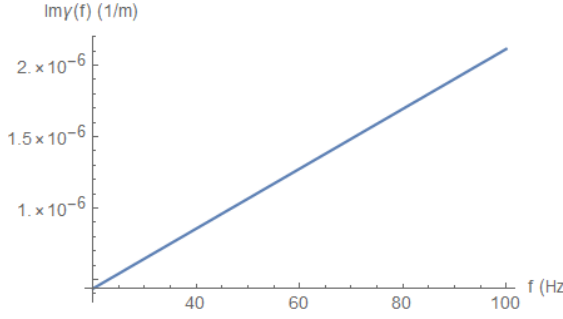
Figure 7. Im γ low frequency dependence.